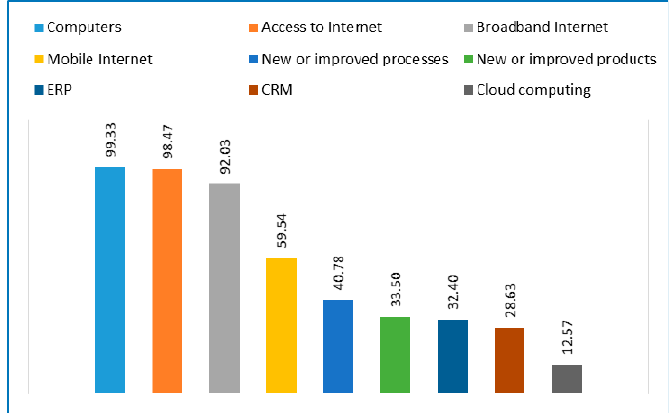
Figure 4. ICT and innovation in the steel industry (manufacturers of basic metals) in Poland. Source: Data from GUS [122].